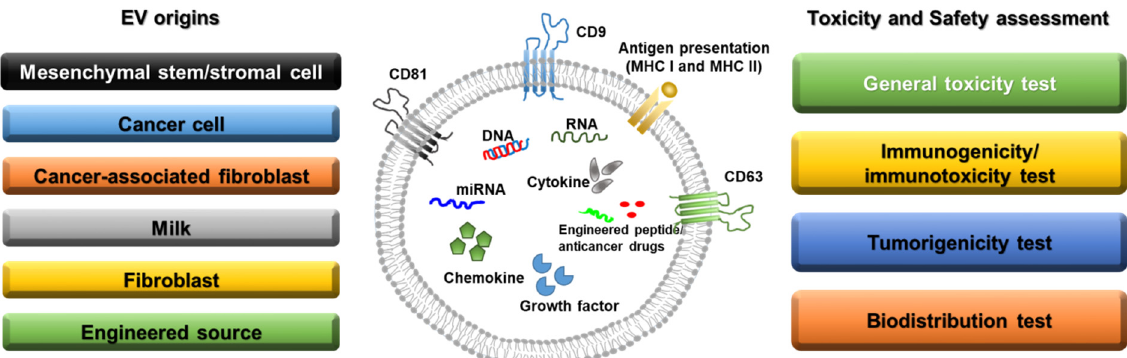
Figure 1. Sources of extracellular vesicles and toxicity/safety assessments. EVs can originate from mesenchymal stem/stromal cells, cancer cells, cancer-associated fibroblasts, milk, normal fibroblasts, and engineered cells. EVs have a lipid bilayer and can contain transmembrane proteins, antigen presentation proteins, DNA, RNA, miRNA, cytokines, chemokines, growth factors, engineered peptides, and anticancer drugs. Before clinical studies of EVs, general toxicity, immunogenicity, tumorigenicity, and biodistribution tests should be performed in preclinical studies depending on the source of the EVs.